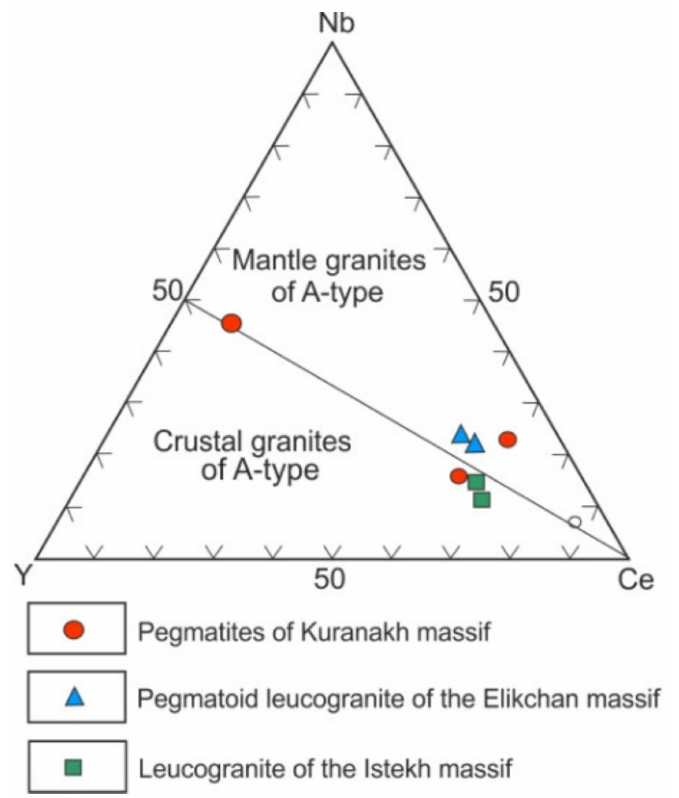
Figure 12. Y–Nb–Ce diagram for magmatic rocks of the Khara–Sis massif. Fields on the diagram are from